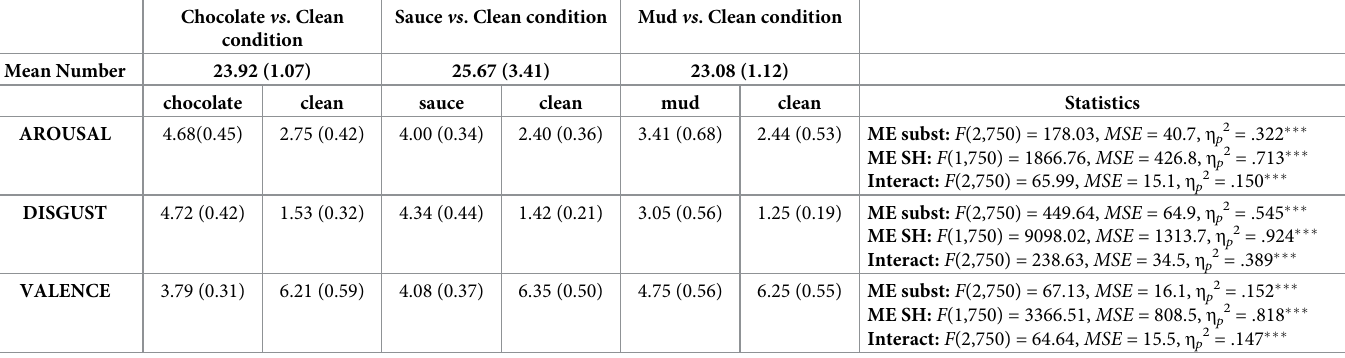
Table 6. Mean number of responses (and SD) obtained per image condition and mean ratings (and SD) of arousal, disgust and valence in each image condition when no context was presented. Chocolate vs . Clean condition